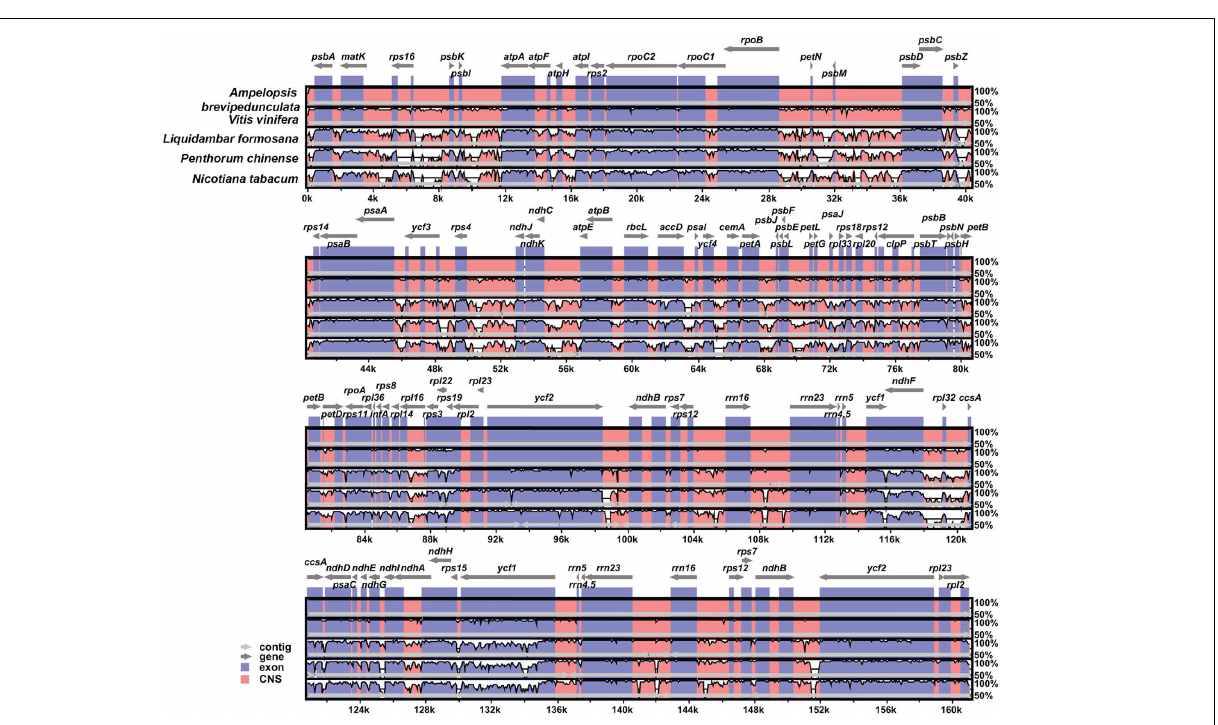
Frontiers in Plant Science |